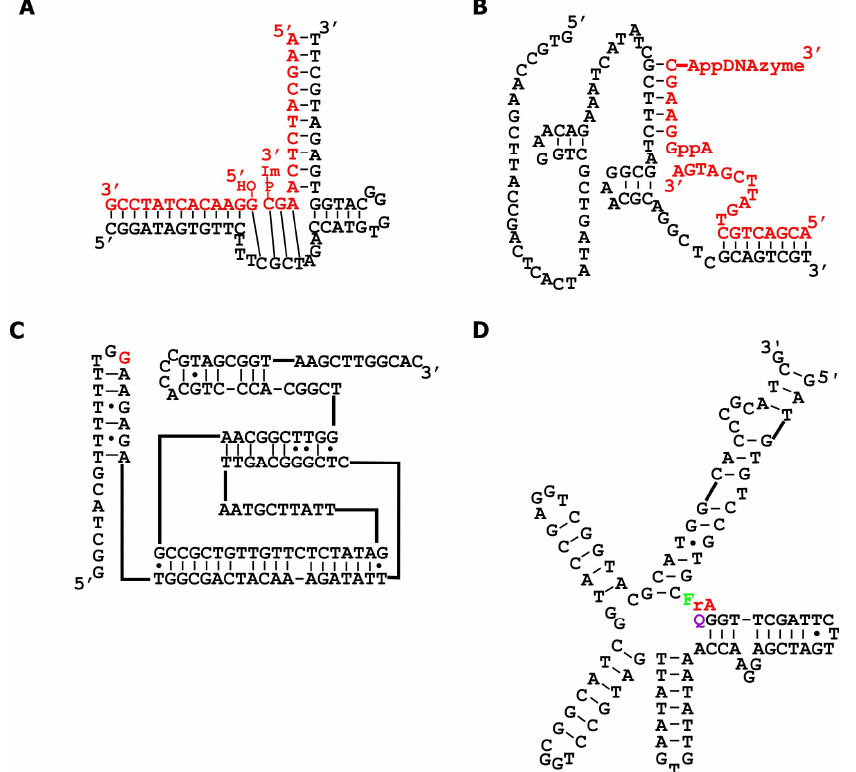
Figure 2. Deoxyribozymes with different secondary structural arrangements. (A) Structural model of the E47 ligase deoxyribozyme. Substrates are shown in red. OH represents a 5 ′ hydroxyl and P-Im represents a 3 ′ phophorimidazolide. Solid lines represent Watson-Crick base-pair interactions. (B) Secondary structural model of the L78 DNA ligase deoxyribozyme. 5 ′ ,5 ′ pyrophosphate cap is represented by ppA. (C) Secondary structural model of the 10-28 N-glycosylase deoxyribozyme. Site of glycosylation is shown with a red G. Circles represent G-T wobble base-pairs. (D) Secondary structural model of 5J-A28, an RNA-cleaving, fluorescence-generating deoxyribozyme. F and Q represent a fluorescein- and a DABCYL-containing deoxythymidine, respectively. rA denotes adenine